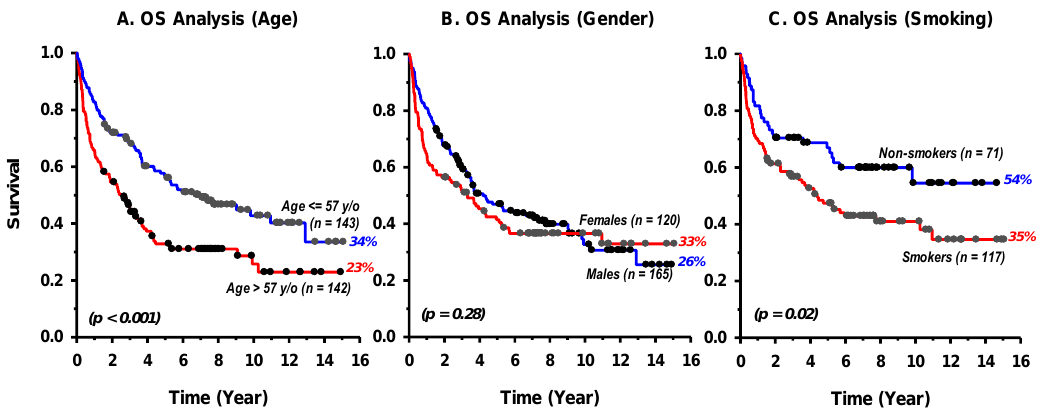
Figure 2. Kaplan – Meier Log- Rank overall survival (OS) analysis by patients’ characteristics of groups of age ( A ), gender ( B ), and smoking status ( C ) for 285 patients with head and neck squamous cell carcinomas.